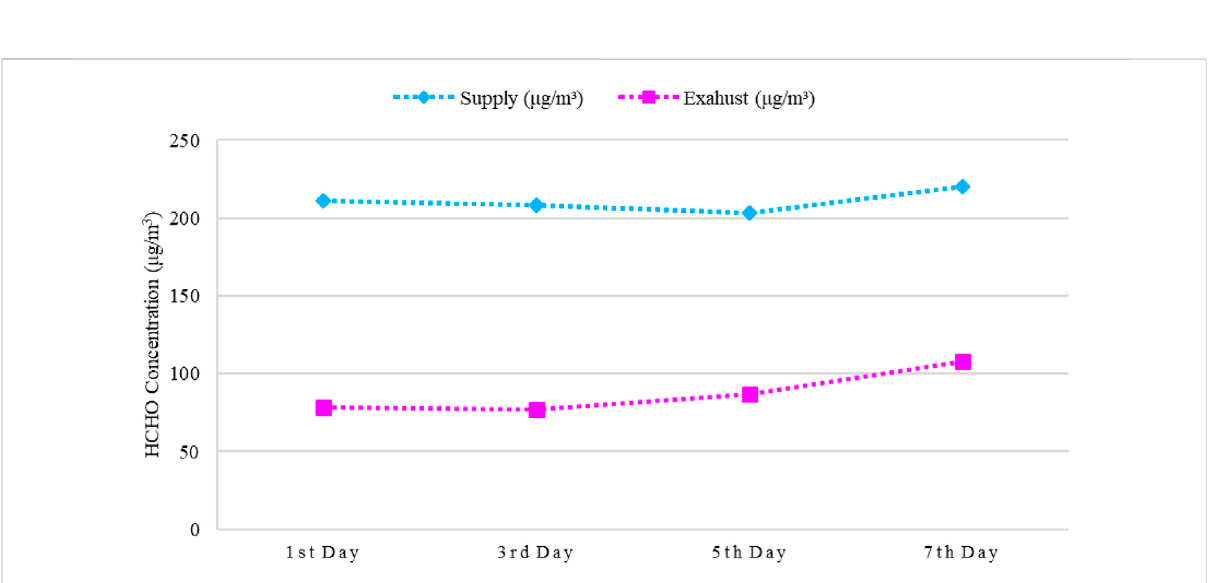
FIGURE 5 HCHO Adsorption Test Result (Normal wallpaper with